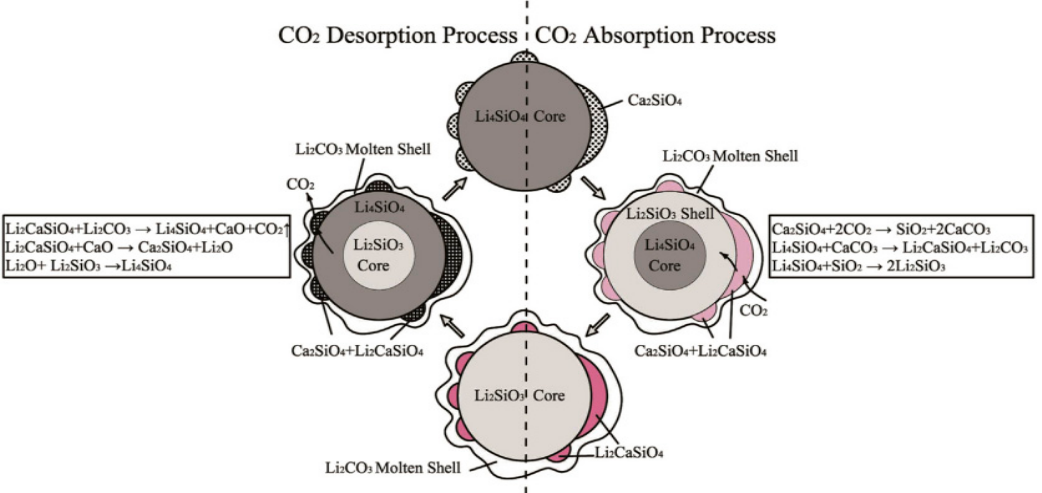
Figure 9. CO 2 absorption and regeneration mechanism of Ca-doped Li 4 SiO 4 [51].